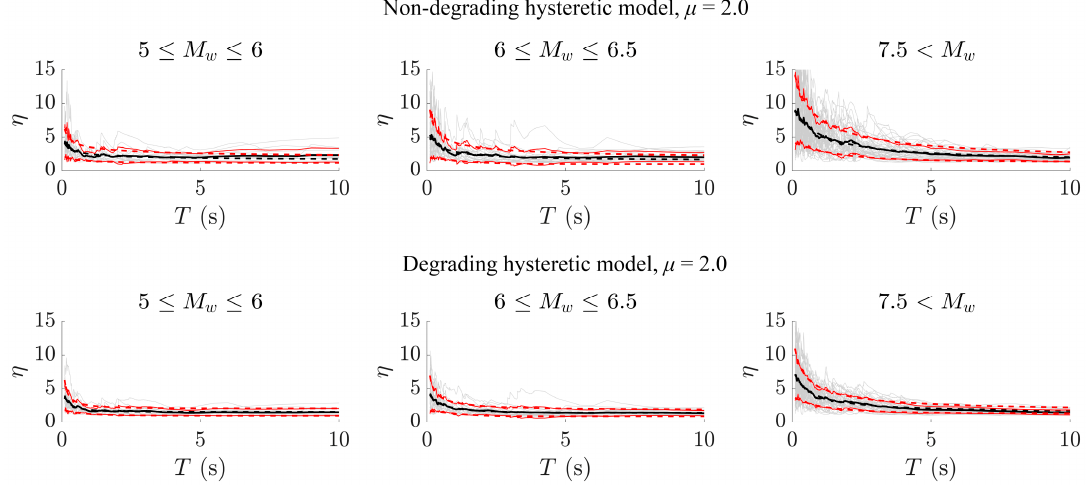
Figure 13. Comparison between calculated cumulative plastic deformation ratio η spectra (mean and mean ± one standard deviation) and proposed approximation (thin solid line: single spectrum; thick solid line: calculated spectrum; thick dashed line: proposed approximation).